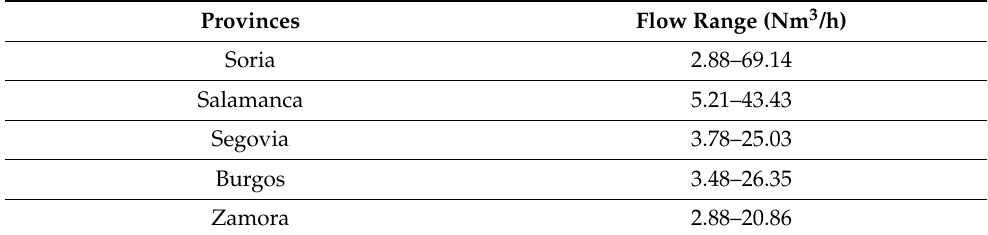
Table 7. Range of production flows in selected provinces.